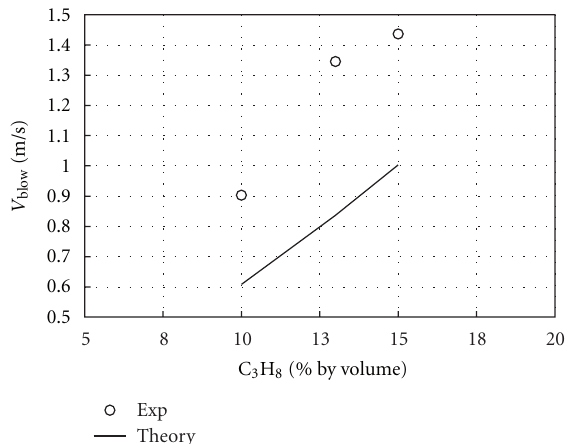
Figure 14: Blow-o ff velocity for nitrogen-diluted mixtures of C 3 H 8 .